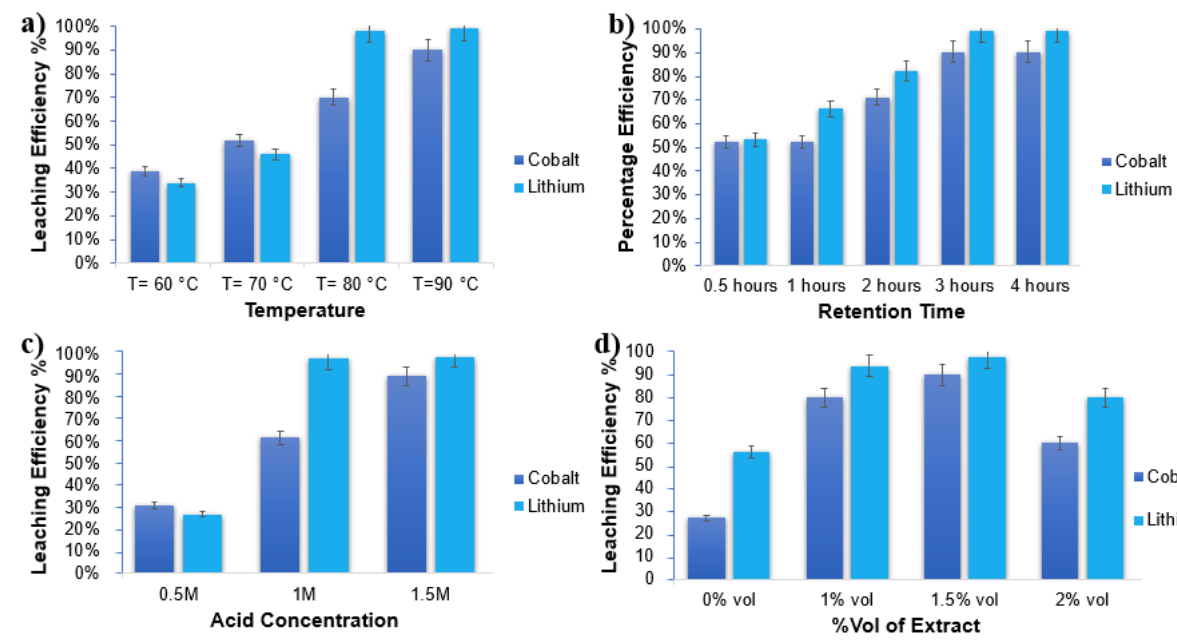
Figure 2. ( a ) Impact of temperature on leaching efficiency. ( b ) Impact of retention time on leaching efficiency. ( c ) Impact on the acid concentration of leaching efficiency. ( d ) Impact of extract vol% on leaching efficiency.